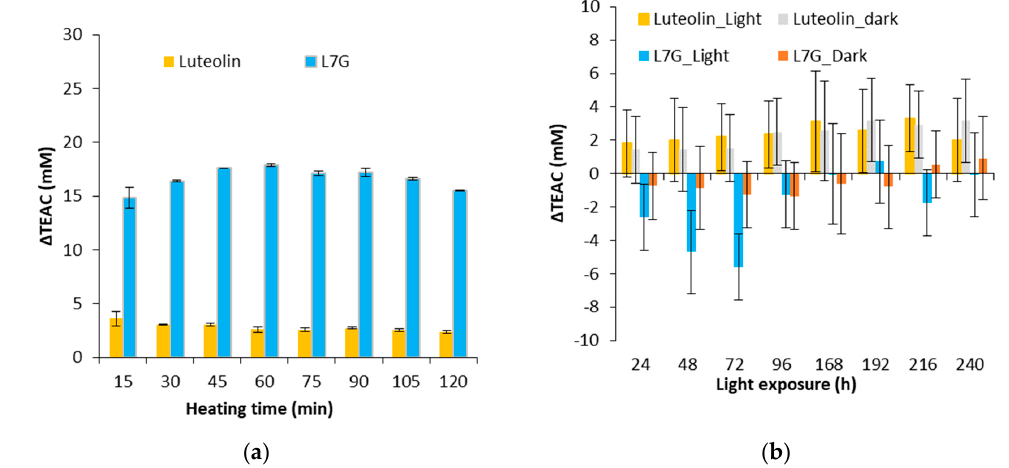
Figure 4. Evolution of Δ TEAC for flavones (luteolin and luteolin 7- O- glucoside) for a thermal treatment of 130 °C ( a ) and an exposure to light ( b ).